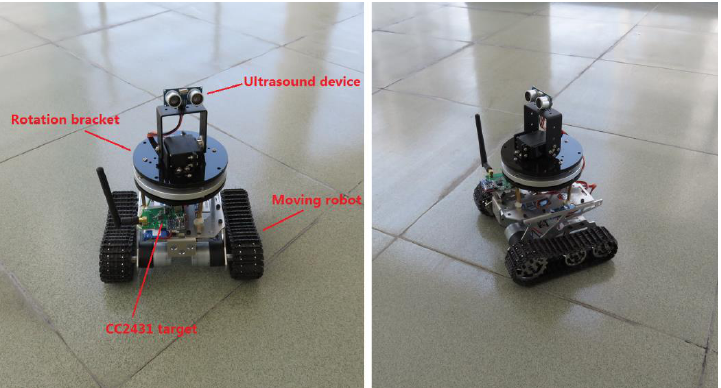
Figure 5. Illustration of the automatic calibration equipment.